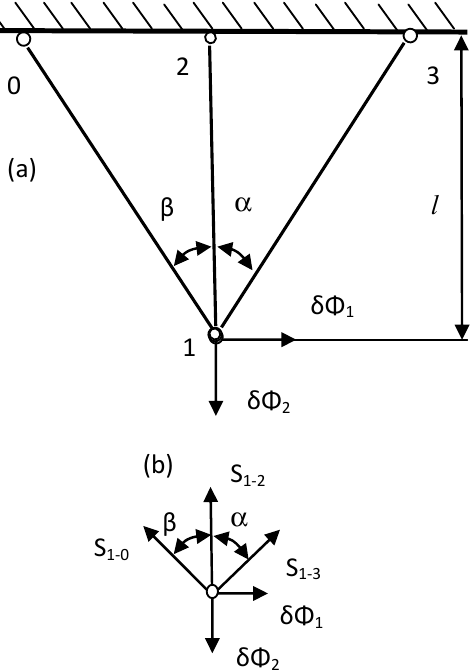
Figure 2. Three-rod system: ( a ) design scheme and ( b ) node 1.